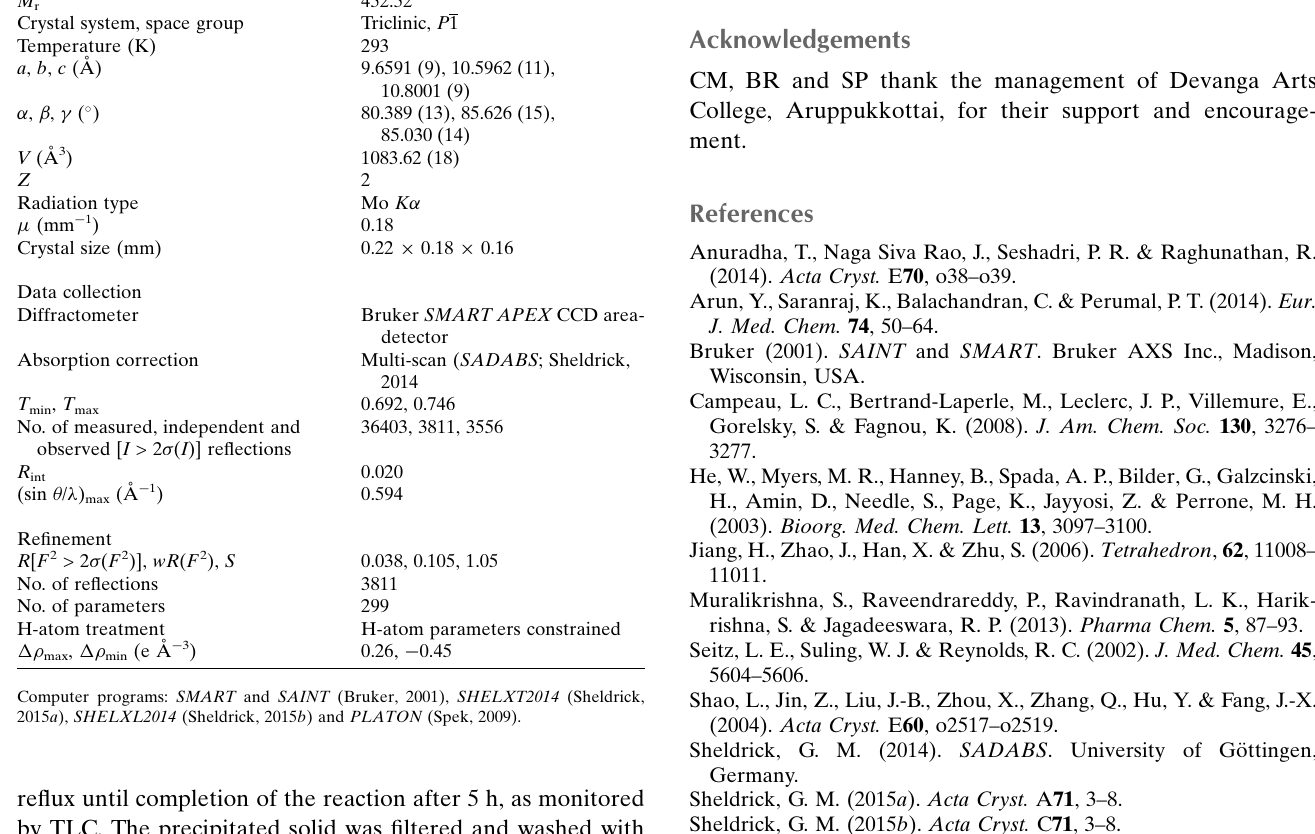
Table 2 Experimental details. Crystal data Chemical